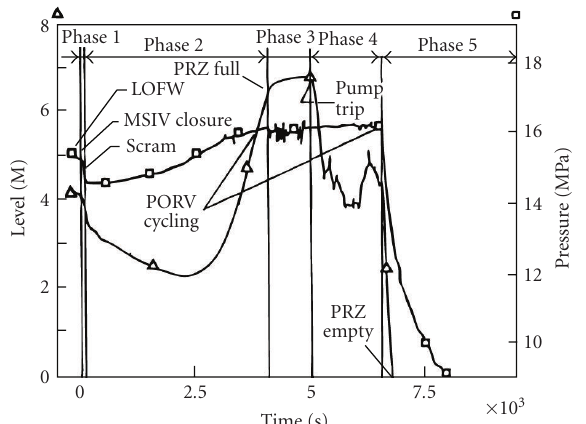
Figure 4: ISP-22 (SPES): experimental trends of pressurizer pres- sure and level.